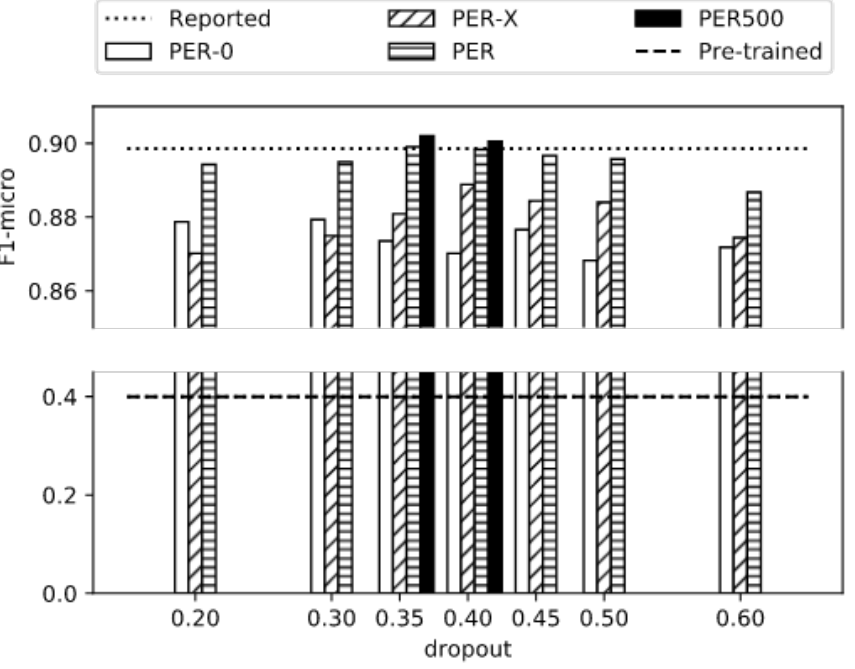
Figure 3. F1-micro results of training SpaCy starting from model